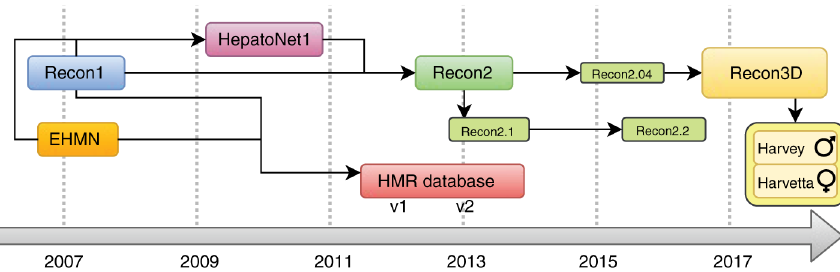
Figure 1: Timeline of the development of human GSMMs from 2007 until the present day. This accounts only for generic models but the HepatoNet1 hepatocyte model is included as a contribution for Recon2. Each model is represented by a rounded box. Revisions and derivative models are distinguished by a black border and smaller